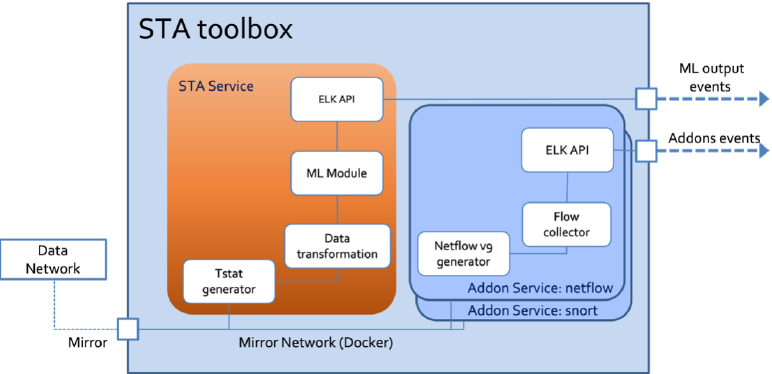
Figure 5. STA toolbox with two